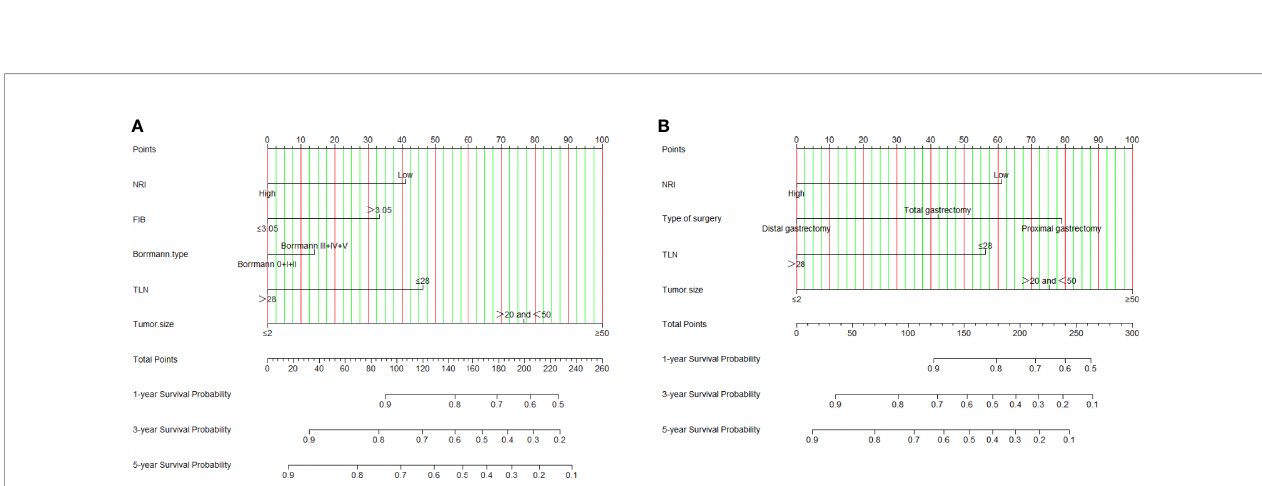
FIGURE 2 | Disease free survival (DFS) and overall survival (OS) of patients with stage III gastric cancer. (A) Kaplan-Meier analysis of DFS for the NRI, (B) Kaplan- Meier analysis of OS.